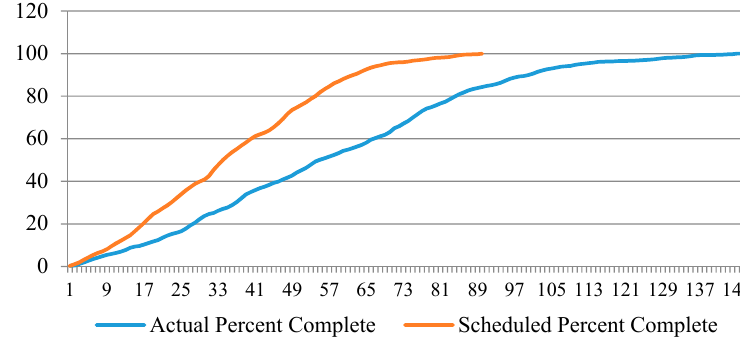
Figure 5. Percent completion of the simulated project.